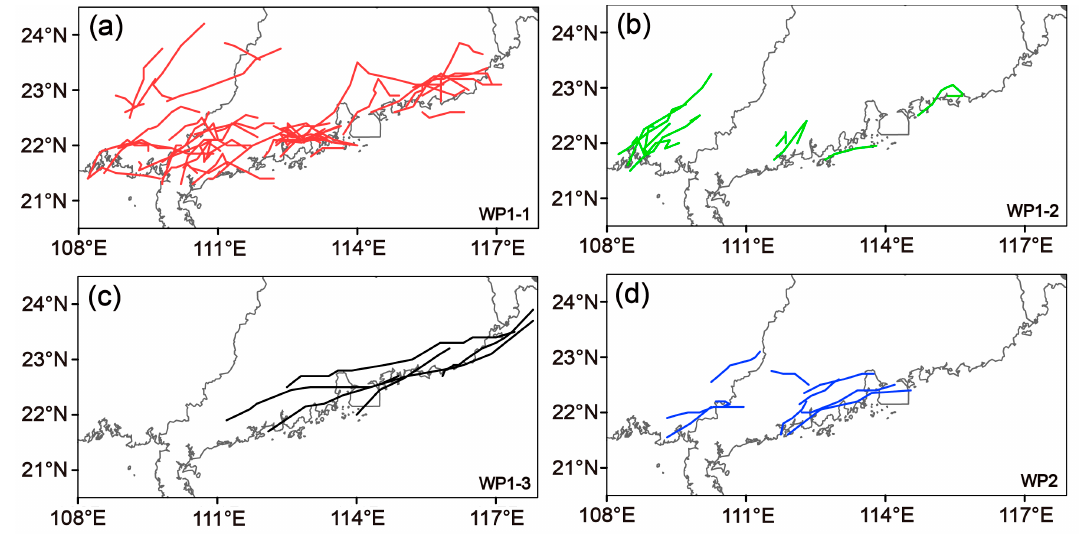
Figure 15. Motion paths (eastward) of hourly rainfall for the OWSRs under the vertical wind profiles of ( a ) WP1-1, ( b ) WP1-2, and ( c ) WP1-3 in the SWLLJ situation and ( d ) the vertical wind profile of WP2 in the ACR situation. ( a ), ( b ), ( c ) and ( d ) are drawn from 46, 10, 5, and 10 OWSR events.